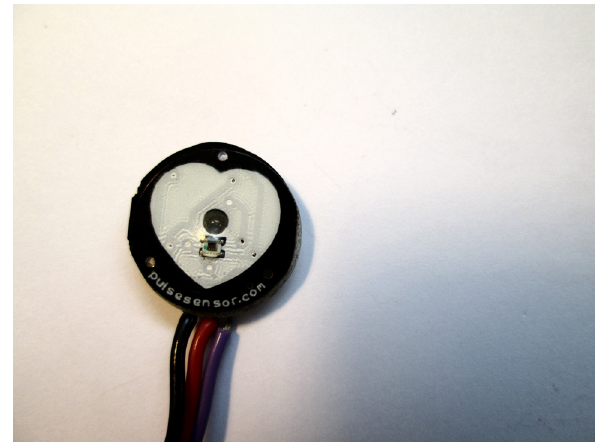
Figure 10: Pulse sensor amped.